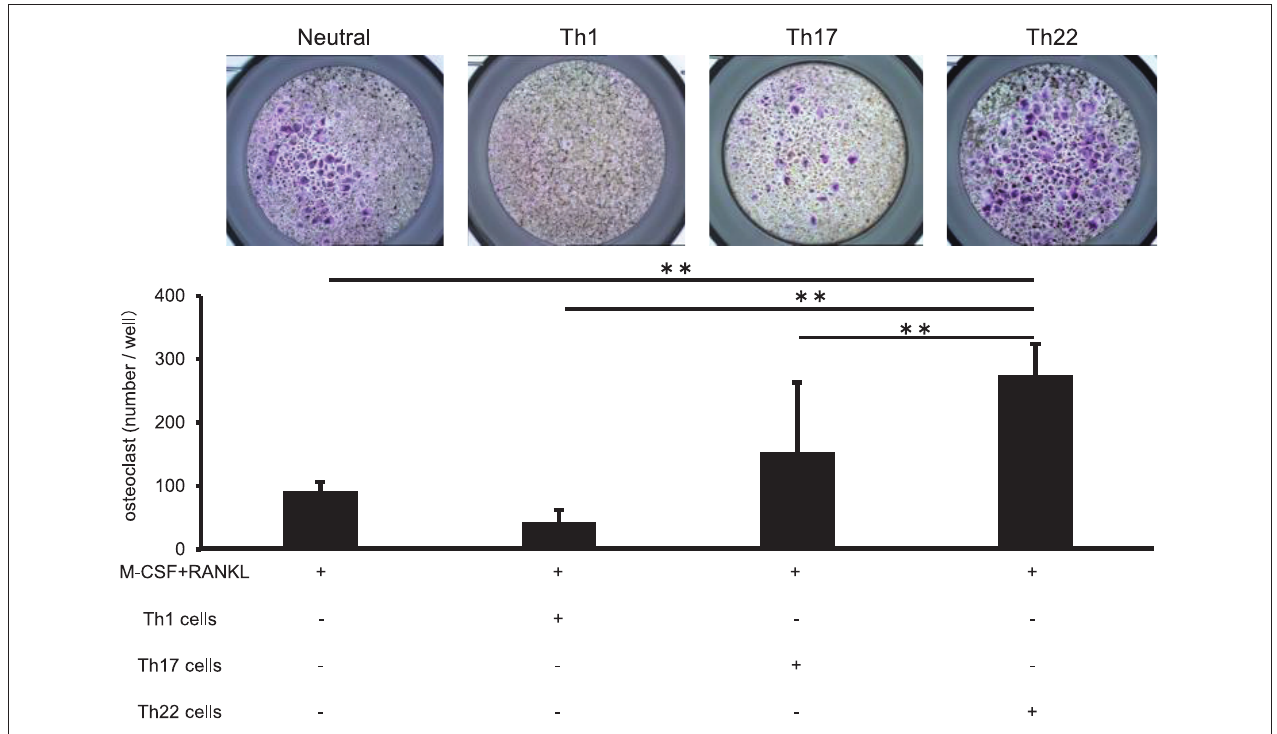
FIGURE 5 | IL-22 promotes osteoclast differentiation. (A) Osteoclast differentiation from human monocytes following stimulation with M-CSF (50ng/mL) and RANKL (50ng/mL) in the absence (Neutral) or presence of IFN- γ (0.1, 1, or 10ng/mL), IL-17 (0.1, 1, or 10ng/mL), or IL-22 (0.1, 1, or 10ng/mL). TRAP-positive, multi-nucleated cells were identified using leukocyte acid-phosphatase staining; representative image of five independent experiments ( left ; magnification: 200 × ). TRAP-positive cells were counted ( right ). All data represent the mean ± standard deviation of five independent experiments. (B) The expression of NFATc1 and cathepsin K mRNA relative to GAPDH in cultures of osteoclasts differentiated in the presence of M-CSF, RANKL, and IL-22 was measured using real-time PCR. All data represent the mean ± standard deviation of five independent experiments. ** p < 0.01 according to the Bonferroni